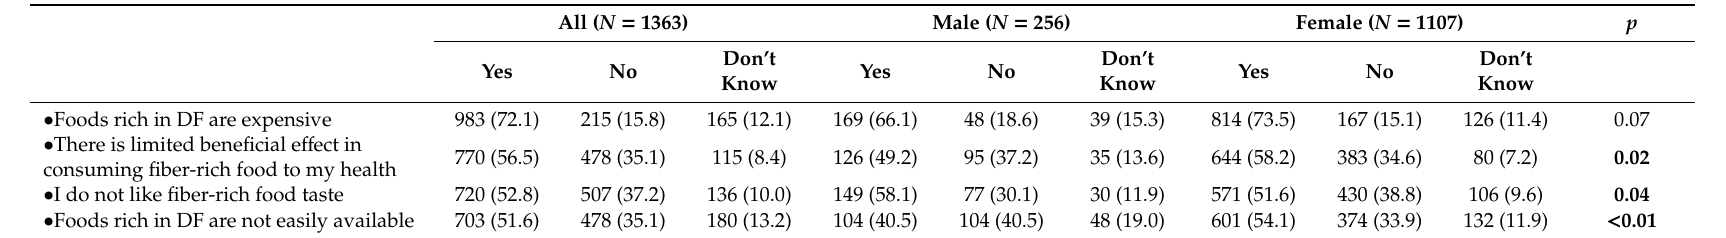
Table 4. Reasons for the lack of DF in the